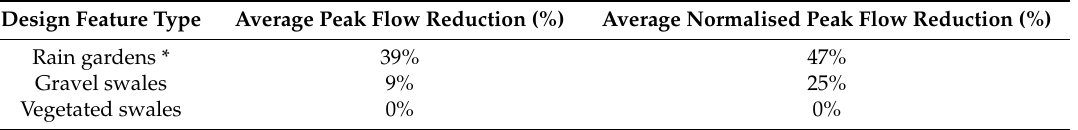
Table 3. Peak flow reduction performance of the various feature types for the 10-year design